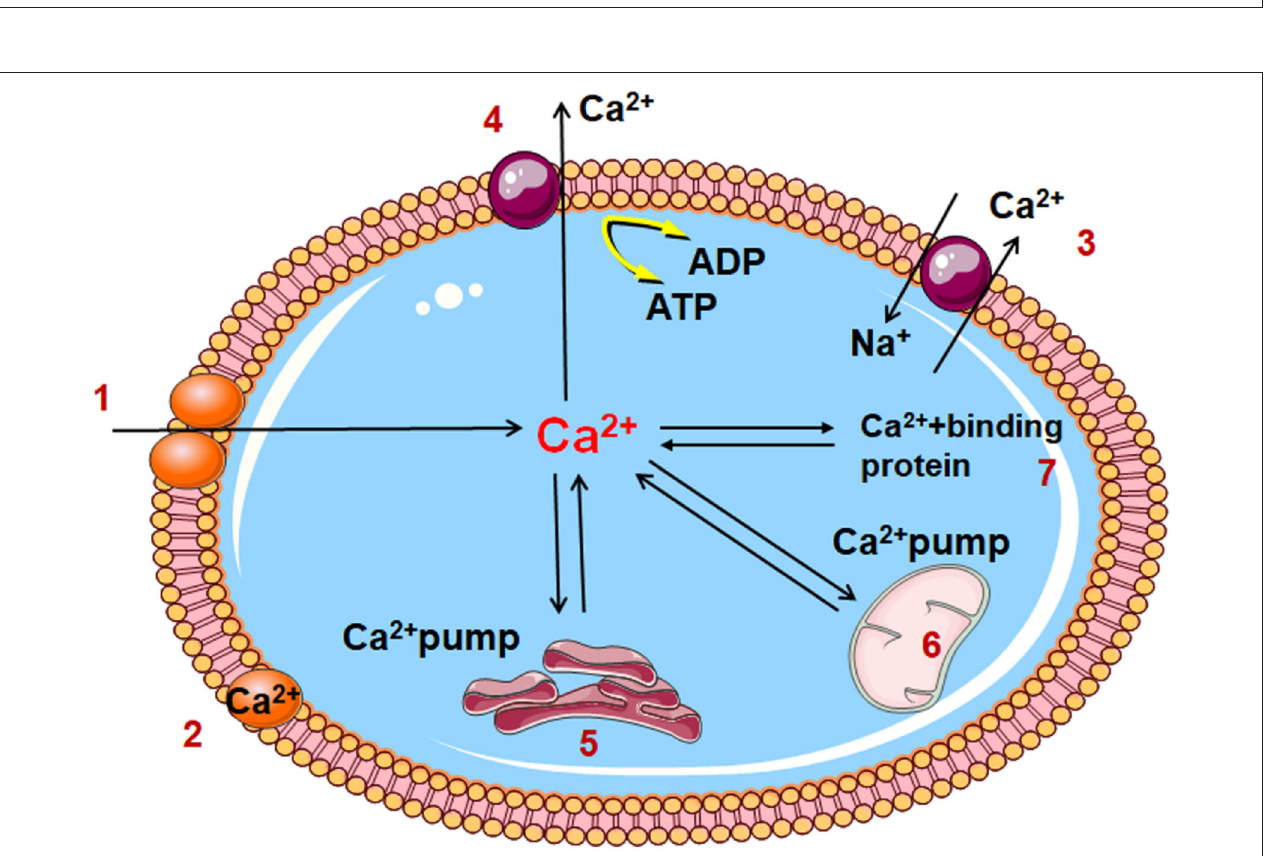
FIGURE 2 | Diagram of cell calcium transport pattern 1. Voltage dependent calcium channel; 2. Cell membrane binding calcium; 3. Na + / Ca 2 + exchange; 4. Calcium channel of cell membrane 5. Sarcoplasmic reticulum; 6. Mitochondria; 7. Cytoplasmic binding calcium; A TP, Adenosine triphosphate; ADP, Adenosine diphosphate.